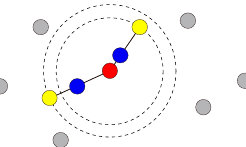
Figure 3. Schematic illustrating the oversampling technique to obtain the same number of healthy control samples to that of the lung cancer patients. After one sample ( red ) is randomly chosen, two samples ( blue ) are randomly interpolated on the lines between the chosen sample and the two nearest samples ( yellow ).